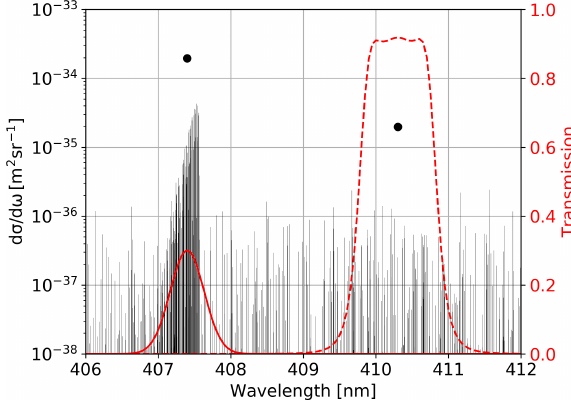
Figure 4. Water vapor Raman cross section spectrum (black lines) is shown together with the transmission of the water vapor channel filter (red line) and the new fluorescence-monitoring channel filter (dashed red line). The total water vapor Raman cross section for these two channels, as the result of integrating the product of the Raman cross section spectrum with the filter transmission of each channel between 406 and 412nm, is also shown (black